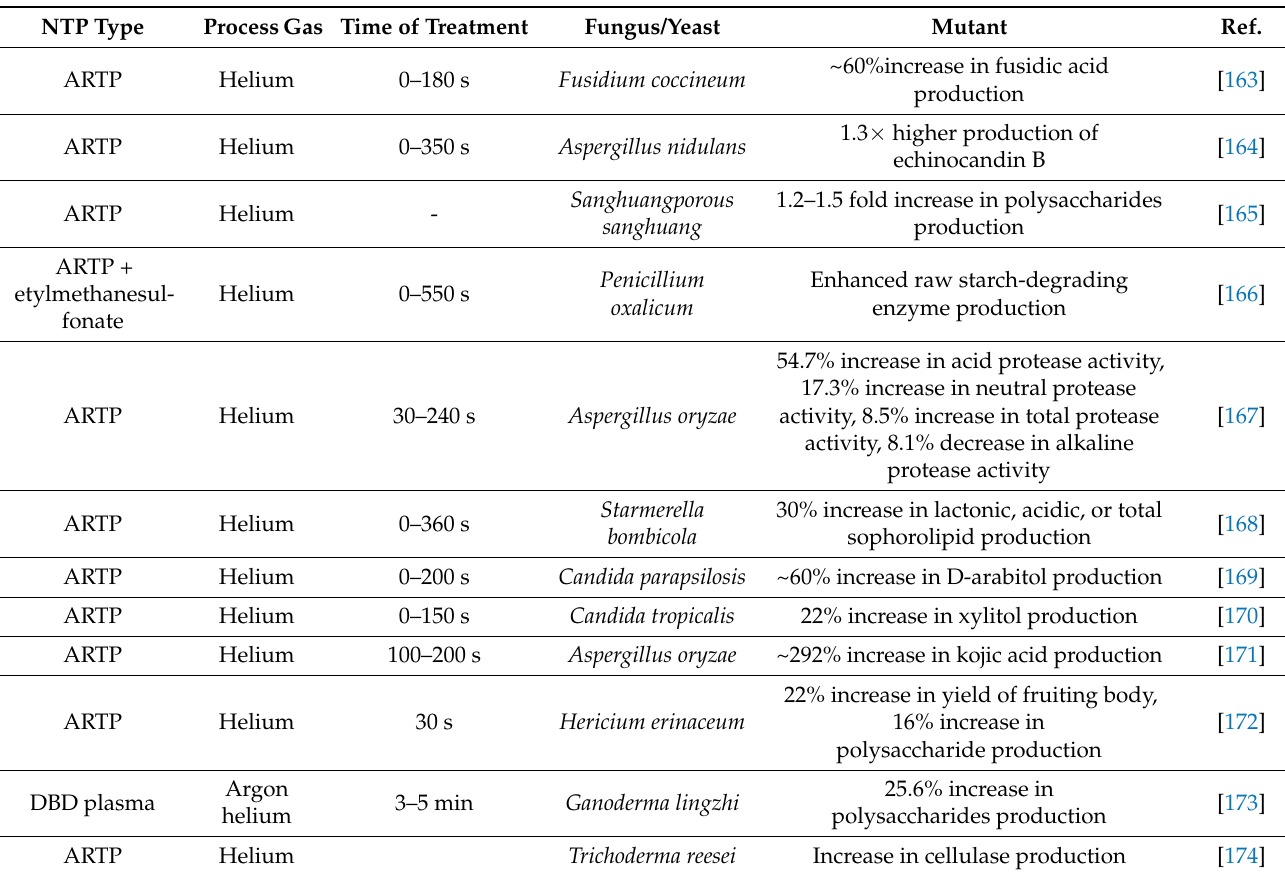
Table 3. Studies using NTPs for mutagenesis of